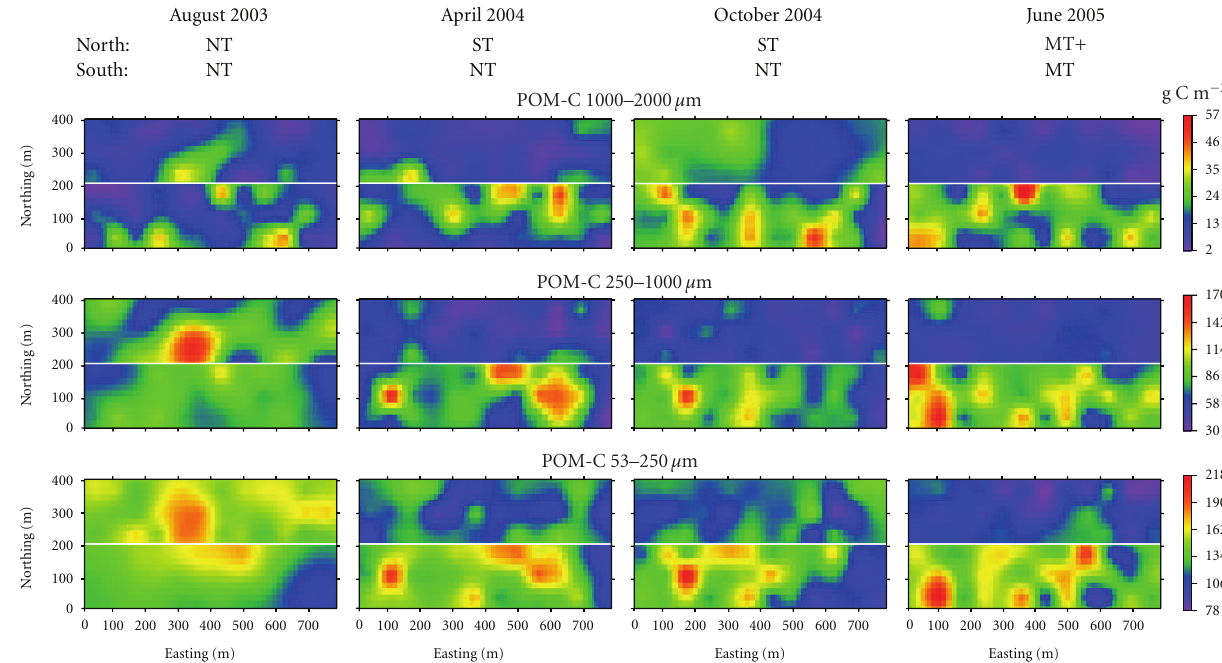
Figure 5: Distribution of soil particulate organic matter C (POM-C) for standard tillage (ST), no-till (NT), and minimum tillage (MT) in the 0–0.15 m depth from August 2003 to June 2005. MT+ indicates one more bed disc (to 0.15 m) pass on the north